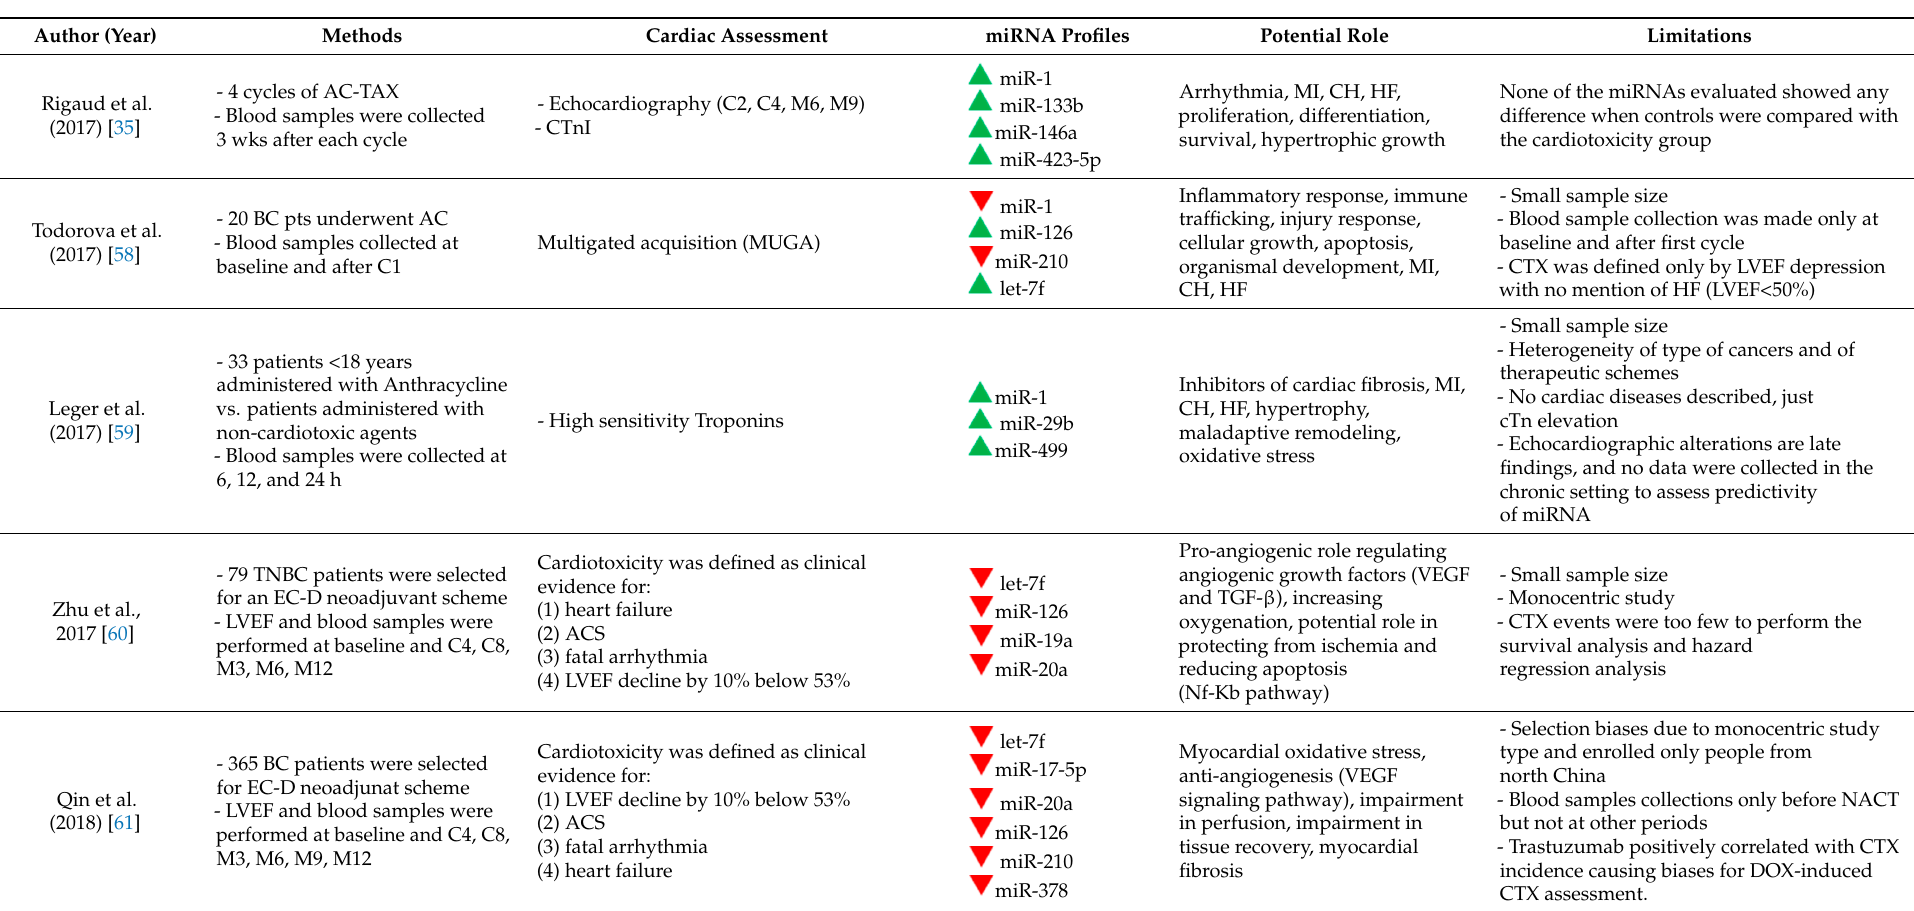
Table 4. Studies focused on miRNAs in human blood samples described in